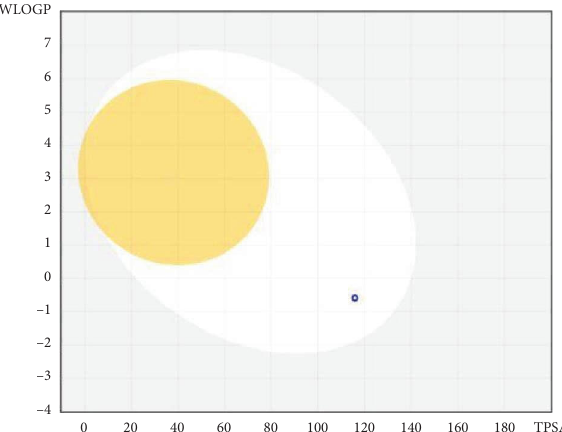
Figure 2: Boiled graph representation of C1.